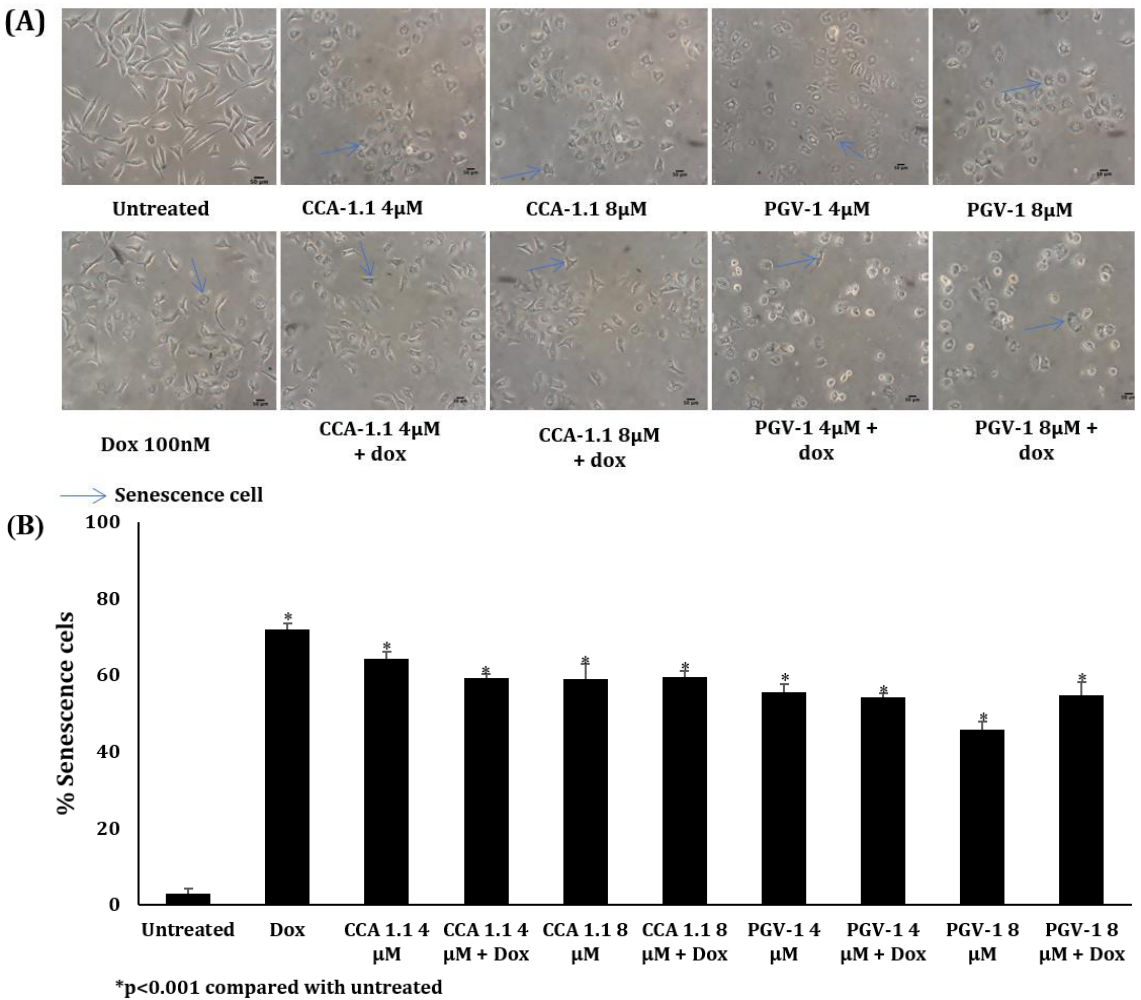
Figure 6. Induction of senescence in T47D cells following treatment with CCA-1.1, PGV-1, or CCA-1.1 + doxorubicin (Dox) treatment. Senescent cells were determined using SA-β galactosidase (Gal) staining assay. Cells (1 × 10 5 cells/mL) were treated with CCA-1.1 or PGV-1 for 24 h and then subjected to SA-  -Gal staining. The percentage of senescent cells (i.e.,  -Gal-positive cells, indicated by blue arrows) was calculated. (A) Cell morphology and (B) percentage of senescent cells. The data are presented as mean ± standard deviation ( n = 3). Differences between treatment groups and untreated group were analyzed using Student’s t -test (* p <